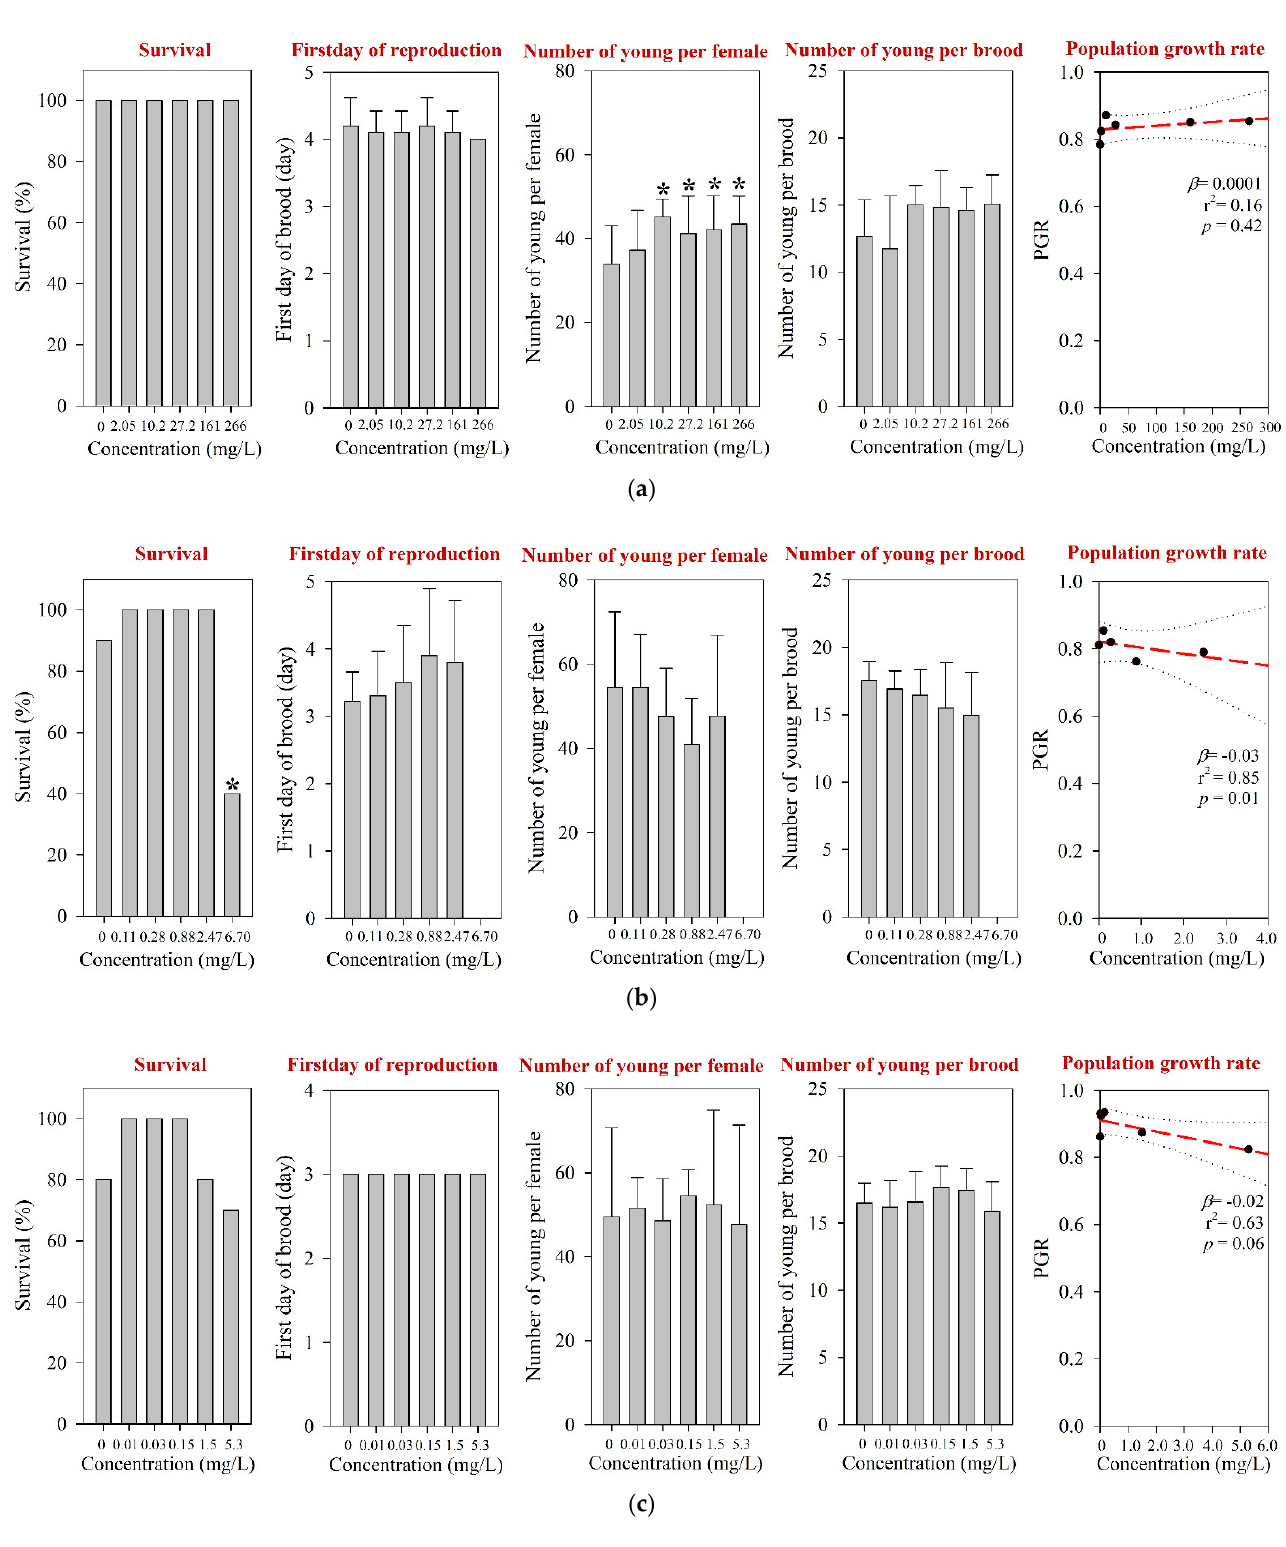
Figure 2. Results of the 7-d chronic M. macrocopa test for ( a ) amoxicillin, ( b ) enrofloxacin, and ( c ) neomycin. The results are shown as mean ± standard deviation ( n = 10). Asterisk (*) denotes a significant difference in the observation endpoint from that of the control ( p < 0.05). Monotonous trend was assumed as the number of young per female of M. macrocopa exposed to amoxicillin ( a ). β , slope; r 2 , coefficient of determination; p , probability value.